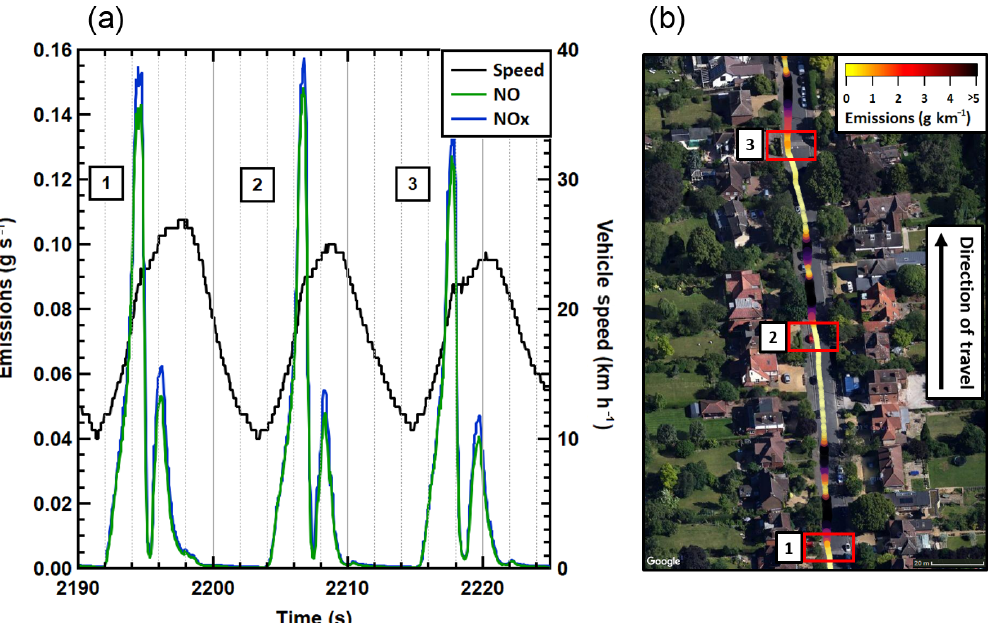
Figure 5. Panel (a) NO x and NO emissions in gs − 1 with vehicle speed, showing the transient behaviour associated with driving over three speed bumps in immediate succession. Panel (b) shows the geolocation of each speed bump (shown in a red box) with a coloured GPS trace showing emissions in gkm − 1 .